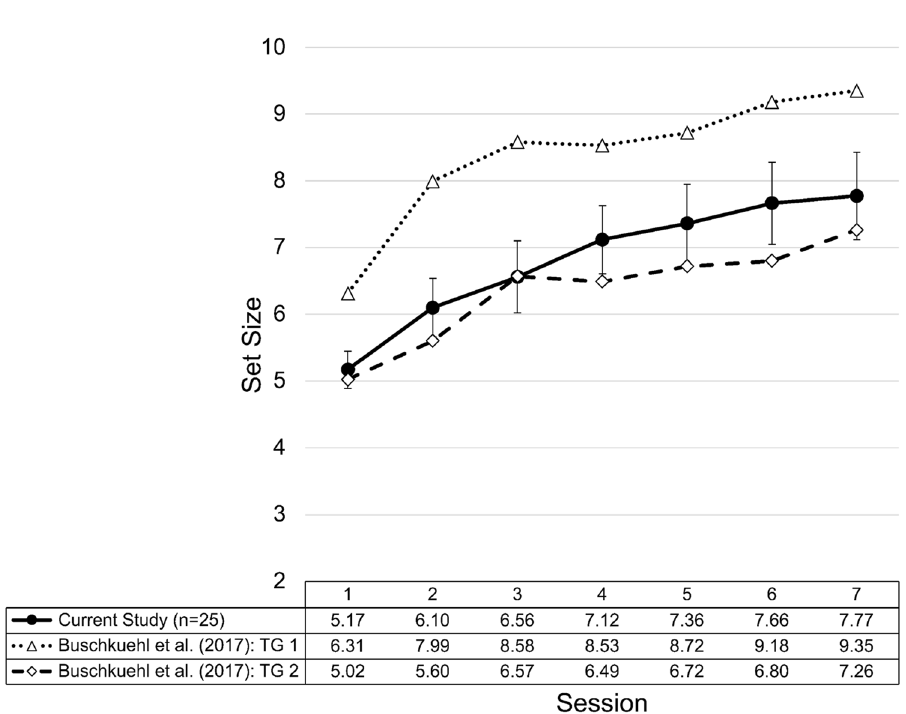
Figure 6. Training curve of the current study compared to the first seven training sessions of the two training groups reported in Buschkuehl et al. 7 . Despite some conceptual task differences, training performance of the current study is similar to that of Training Group 2 (TG2) from Buschkuehl et al. 7 , however, the overall performance is descriptively higher throughout most of the training sessions. Error bars represent standard error of the mean. TG1 stands for ‘Training Group